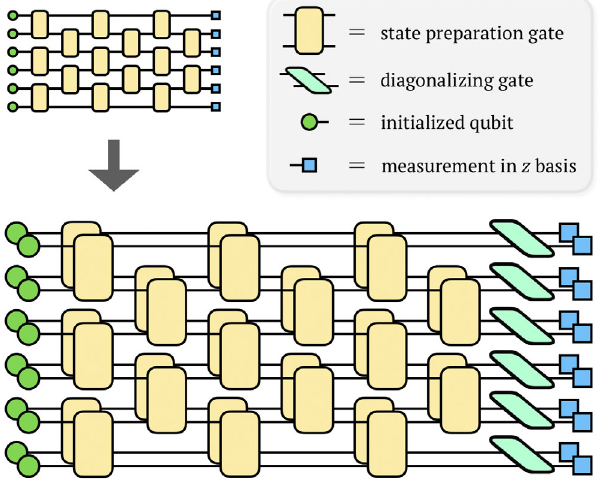
FIG. 3. A circuit diagram of our approach applied to a six-qubit circuit. We use twice the number of qubits to independently perform two copies of the original circuit. We then apply a single layer of the two-qubit gates specified in Eq. (10) before measuring each qubit in the computational basis. This allows us to estimate the error-mitigated expectation values for all single-site Z